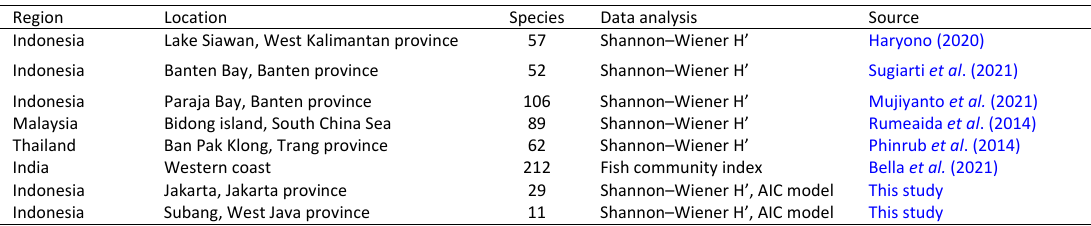
Table 4: Comparisons with current studies on fish community Region